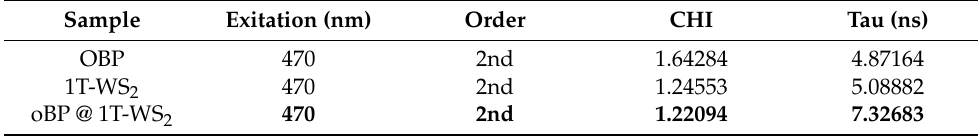
Table 1. Lifetime of Time-resolved PL decays of OBP, 1T-WS 2 and OBP/1T-WS 2